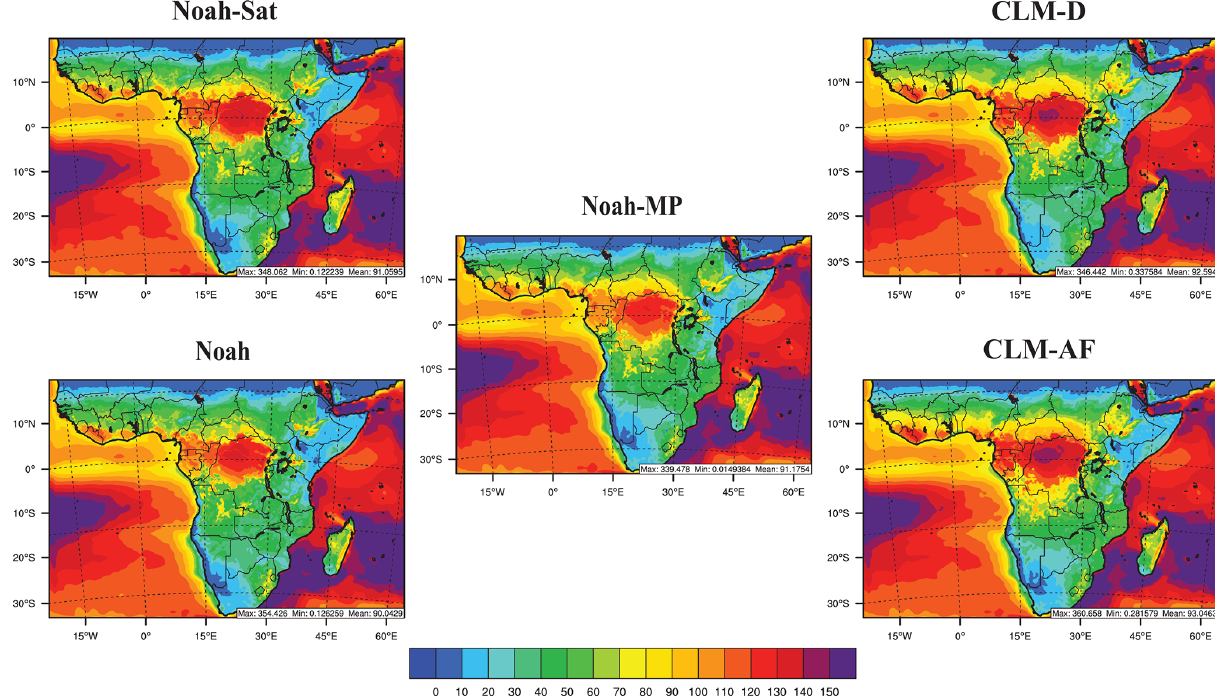
Figure 5. Comparison of annual average latent heat flux (Wm − 2 ) between LSM